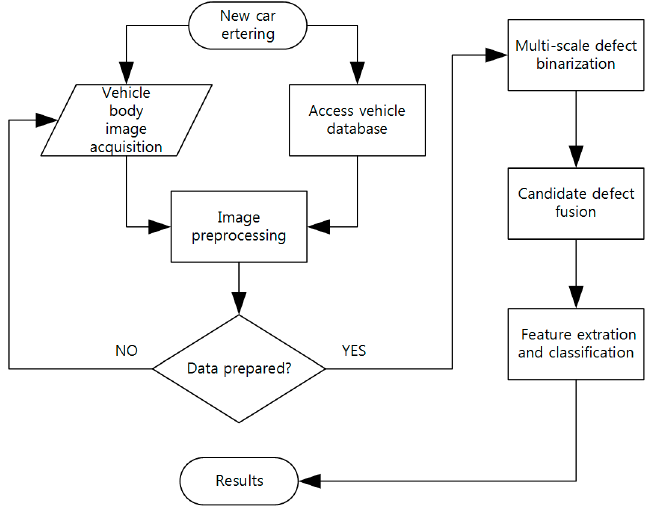
Figure 4. Diagram of image processing subsystem.